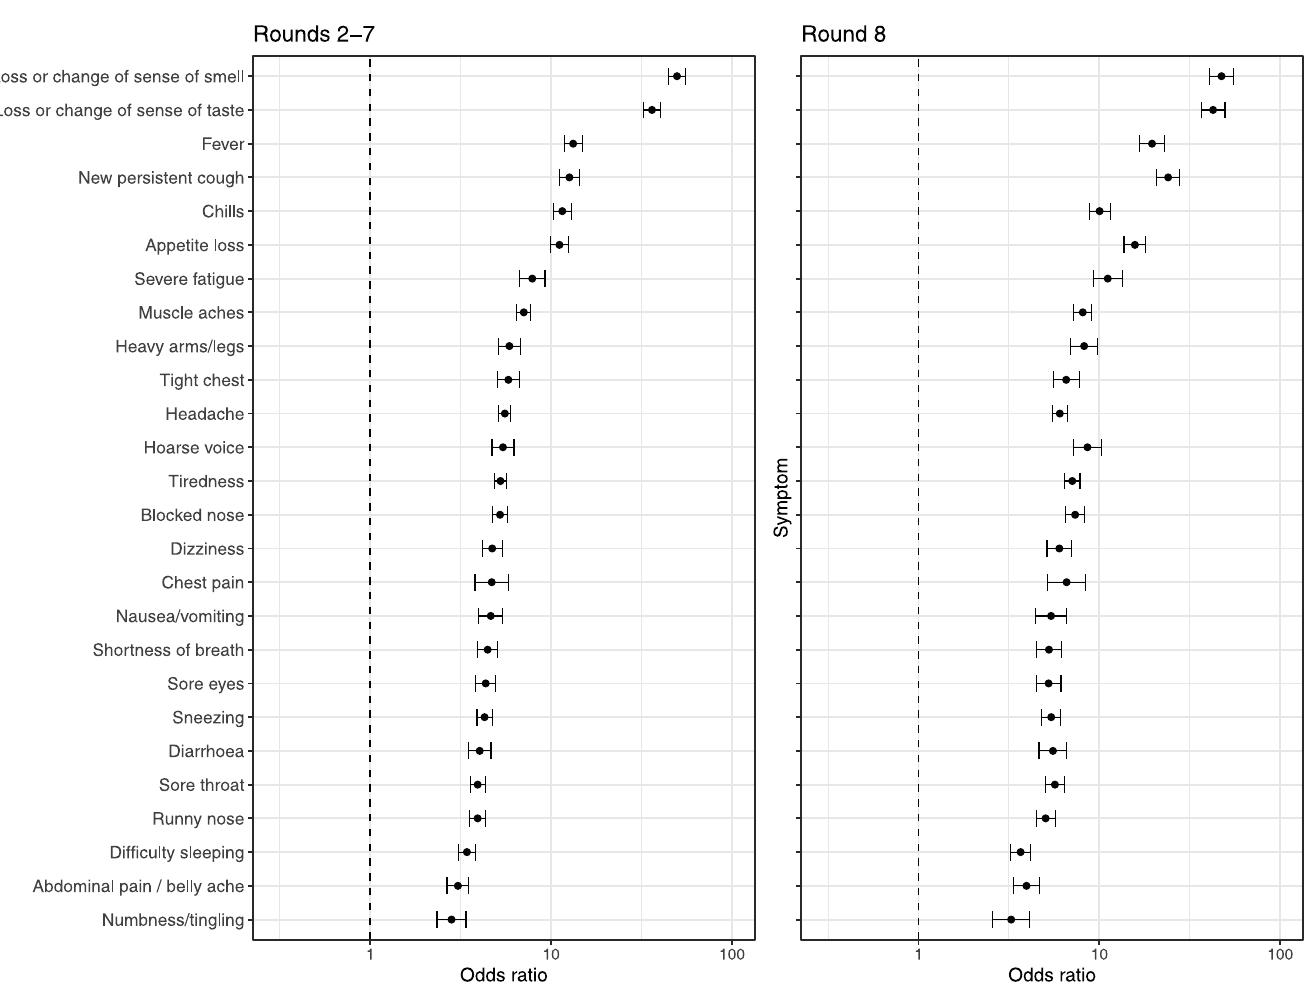
Fig 2. Results from univariate logistic regression models of PCR positivity for 26 surveyed symptoms. Effect size estimates are expressed as odds ratios (95% confidence intervals) in rounds 2–7 (left) and round 8